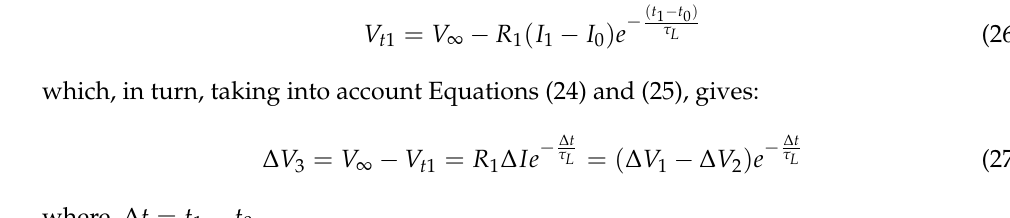
Table 1. Experimental data of the fuel cell current and voltage.